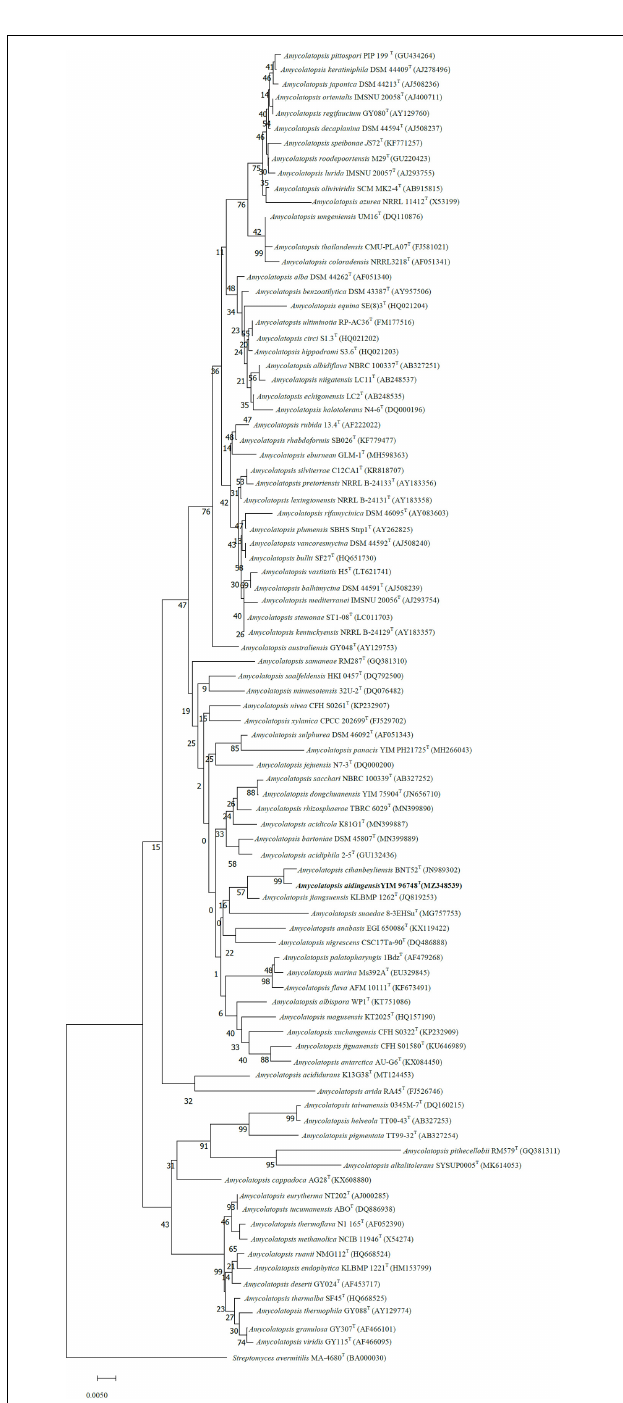
FIGURE 1 | Neighbor-joining tree (MEGA 7.0) showing the relationship between strain YIM 96748 T and related taxa. Streptomyces avermitilis MA-4680 T was used as the